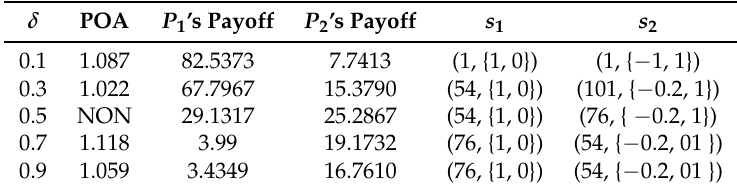
Table 7. Price Of